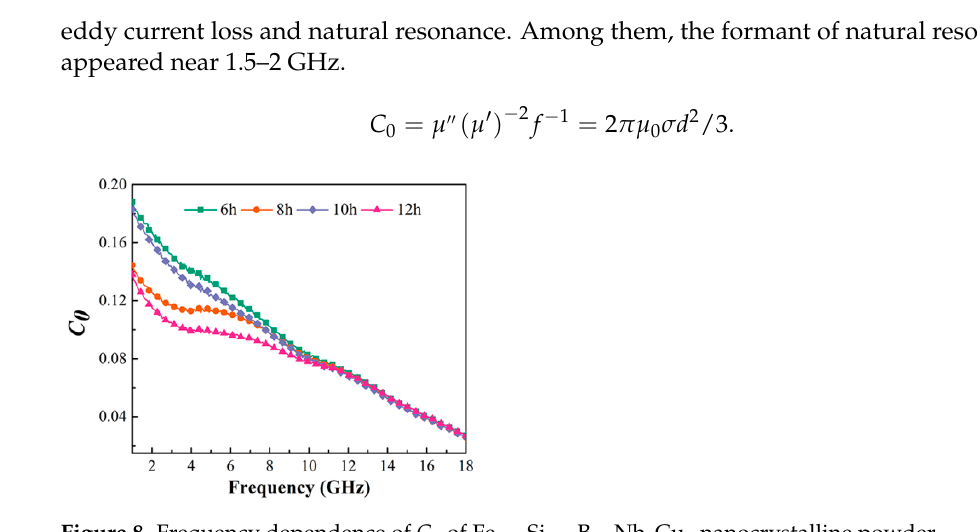
Figure 8. Frequency dependence of C 0 of Fe 73.2 Si 16.2 B 6.6 Nb 3 Cu 1 nanocrystalline powder.